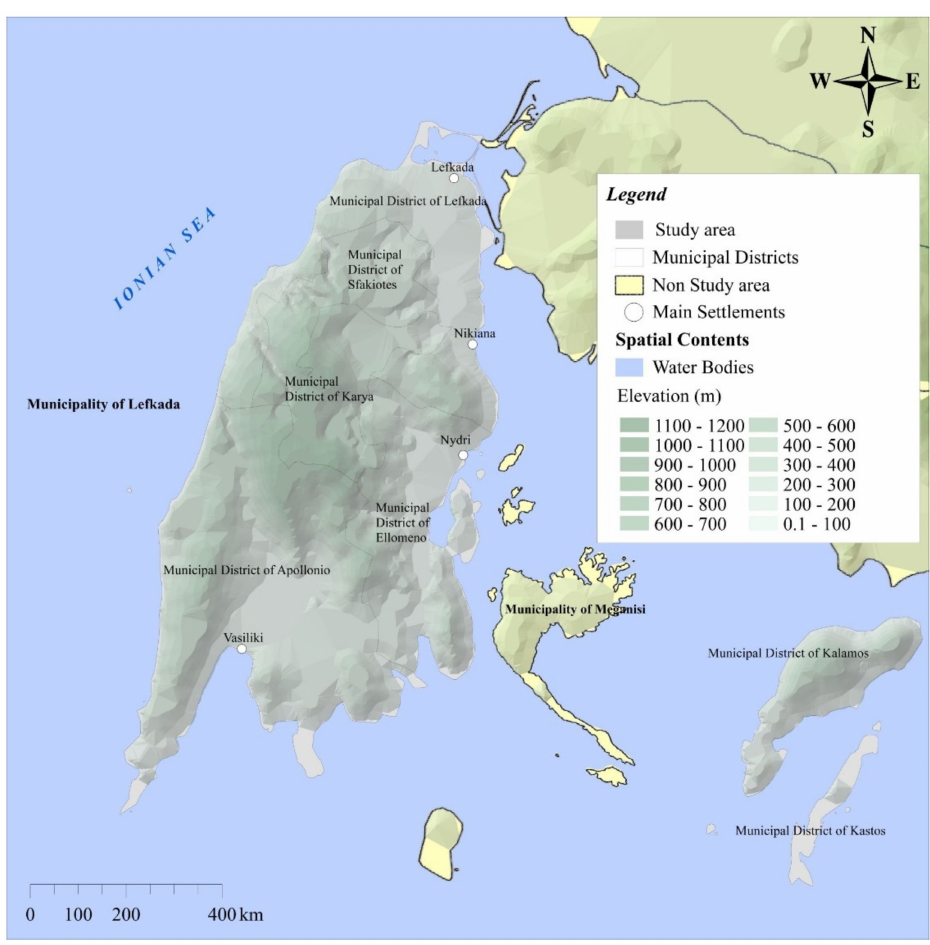
Figure 1. Study area of the present